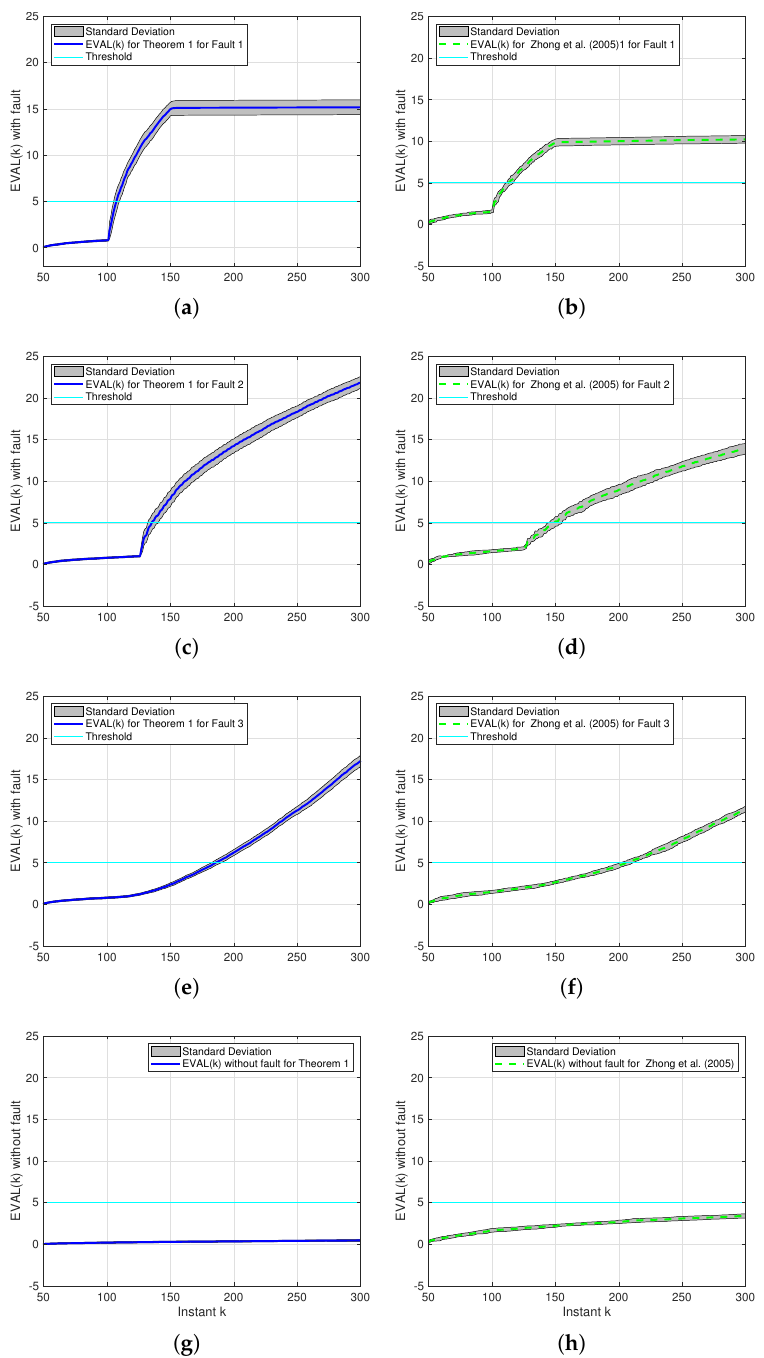
Figure 8. The evaluation function obtained for FDF designed by using Theorem 1 under the assump- tion of knowledge of all modes (to the left), and the FDF provided by [8] (to the right). Both designs are subjected to three type of faults, and also the situation without fault. ( a ) Evaluation function for FDF designed via Theorem 1 subjected to Fault 1. ( b ) Evaluation function for FDF designed via [8] subjected to Fault 1. ( c ) Evaluation function for FDF designed via Theorem 1 subjected to Fault 2. ( d ) Evaluation function for FDF designed via [8] subjected to Fault 2. ( e ) Evaluation function for FDF designed via Theorem 1 subjected to Fault 3. ( f ) Evaluation function for FDF designed via [8] subjected to Fault 3. ( g ) Evaluation function for FDF designed via Theorem 1 without fault. ( h ) Evaluation function for FDF designed via [8] without